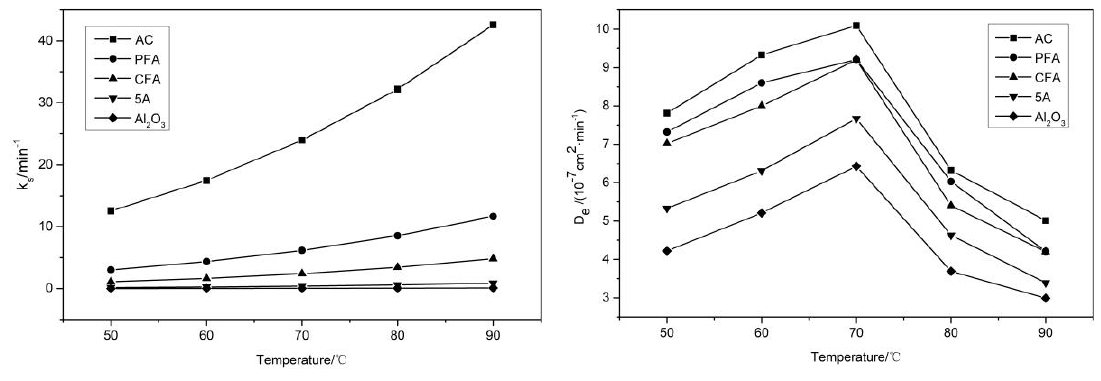
Figure 11. Kinetic parameters of five adsorbents at different temperatures. ( a ): Surface reaction control coefficient ks; ( b ): Internal diffusion coefficient D e . coefficient ks; ( b ): Internal diffusion coefficient D e